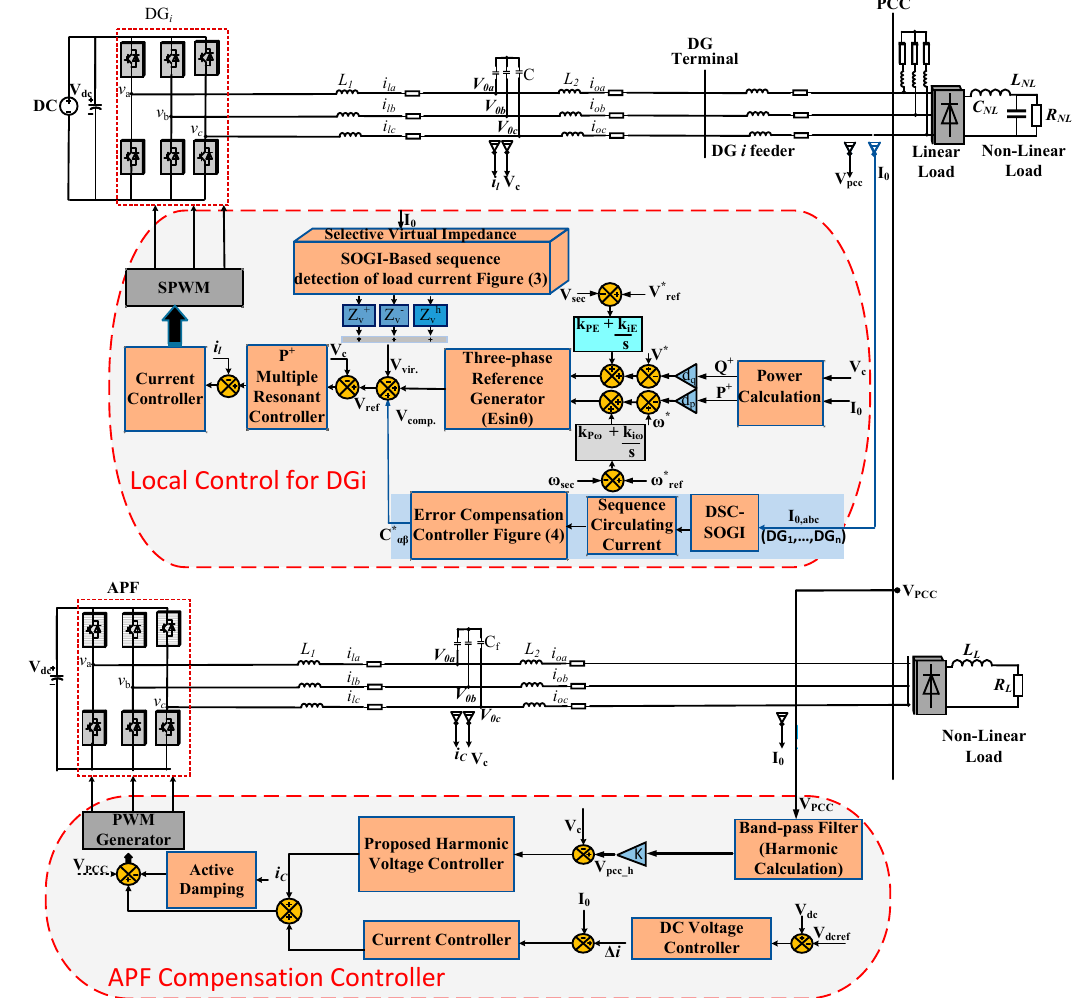
Figure 2. Proposed hierarchical control of DGs and APF.